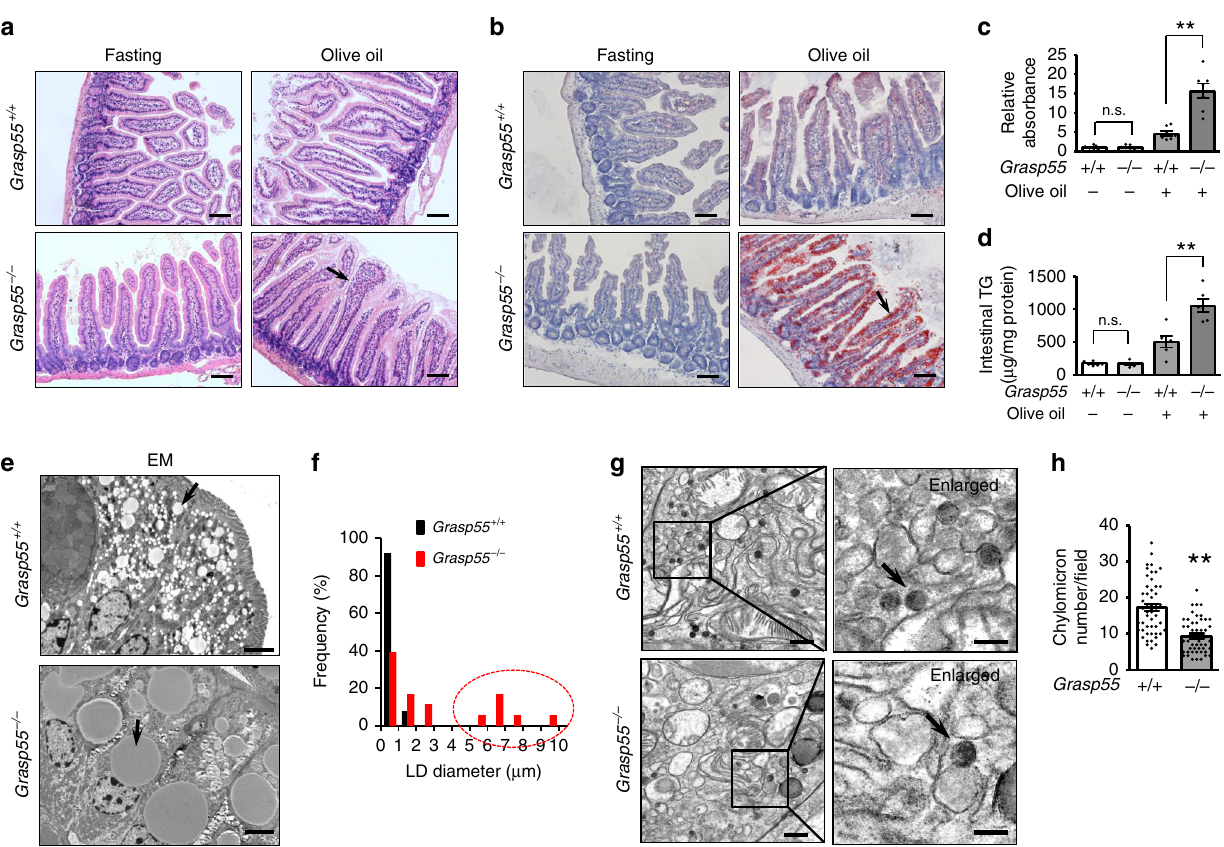
Fig. 3 GRASP55 de fi ciency causes supersized LDs in intestinal epithelium. a – c H&E and Oil Red O staining images of jejunal epithelia. Intestinal tissues were taken from 12-week-old Grasp55 + / + and Grasp55 − / − mice that were fasted for 16 h ( a ) or 4 h after oral gavage of olive oil ( b , 10 μ l g − 1 of body weight). Quanti fi cation of stained lipid droplets (LDs) was performed by measuring sample absorbances at 510 nm ( c , n = 7). The readings were normalized to the background value obtained from a non-induced fasting control. Scale bars: 50 μ m. d Intestinal triglyceride (TG) contents were measured in jejunums of 12-week-old Grasp55 + / + and Grasp55 − / − mice that were fasted for 16 or 4 h after olive oil bolus (olive oil, 10 μ l g − 1 of body weight, n = 6). e Electron-microscopic (EM) images of mouse jejunum 4 h after oral gavage of olive oil (10 μ l g − 1 of body weight). Arrows indicate cytosolic LDs. Quantitative analyses of LD diameters are summarized in ( f ) ( Grasp55 + / + , n = 313 from fi ve mice; Grasp55 − / − , n = 307 from fi ve mice). Dashed circle represents the supersized LD (diameter, >5 μ m). GRASP55 de fi ciency increased the LD size from 0.74 ± 0.02 μ m to 3.19 ± 0.16 μ m ( p < 0.01). Scale bars: 5 μ m. g , h EM images showing chylomicrons of mouse intestinal epithelial cells. Mouse jejunums were prepared 2 h after oral gavage of olive oil. Arrows indicate chylomicron particles. Quantitative analyses of chylomicrons are summarized in ( h ). The number of chylomicron particles in each EM fi eld (3.72× 3.72 μ m) of the Golgi region was determined ( n = 50 from fi ve mice each). Scale bars: 500 nm (enlarged: 200 nm). Data are shown as mean ± SEM. n.s.: not signi fi cant, ** p < 0.01. All p values were calculated by unpaired two-tailed Student ’ s t tests. Source data are provided as a Source Data fi